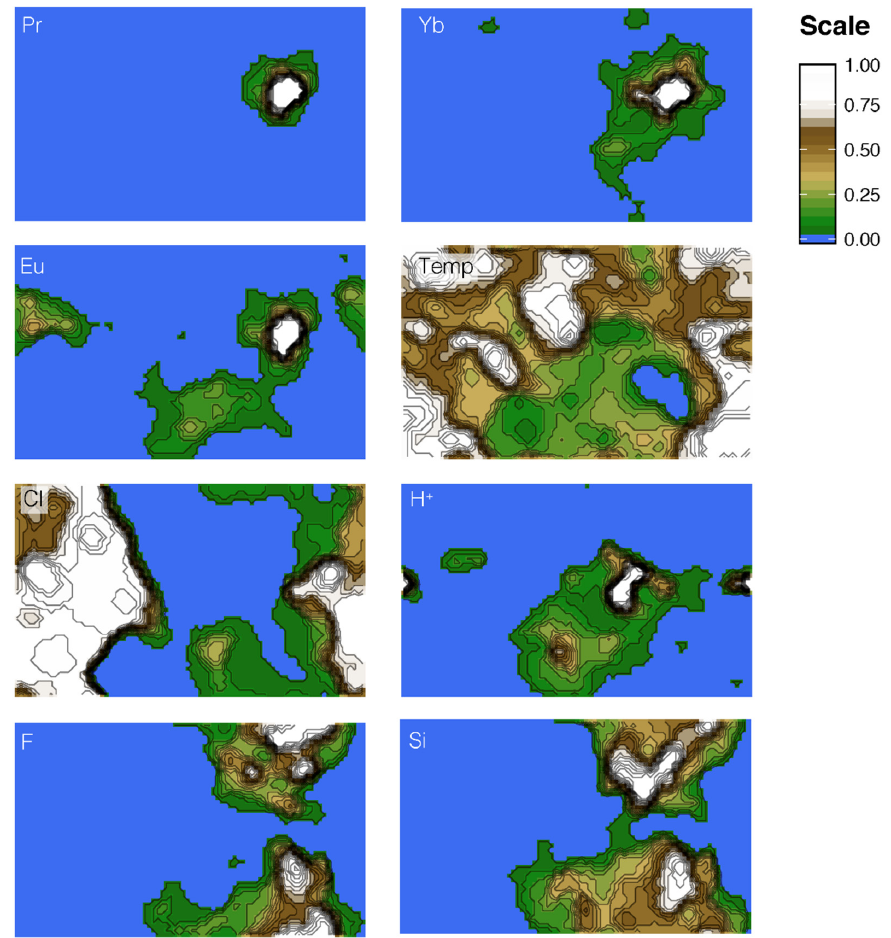
Figure 4. Visualizations of weights from the codebook vectors of the trained ESOM for Pr (proxy light REE), Yb (proxy heavy REE), Eu, estimated reservoir temperature, Cl, H + , F, and Si. Compositional data are in units of relative proportion and were rescaled over the range [0, 1] for mapping. Temperature in units of °C (from ~12 to 230 °C; Figure 2) were rescaled over the range [0, 1] for mapping.